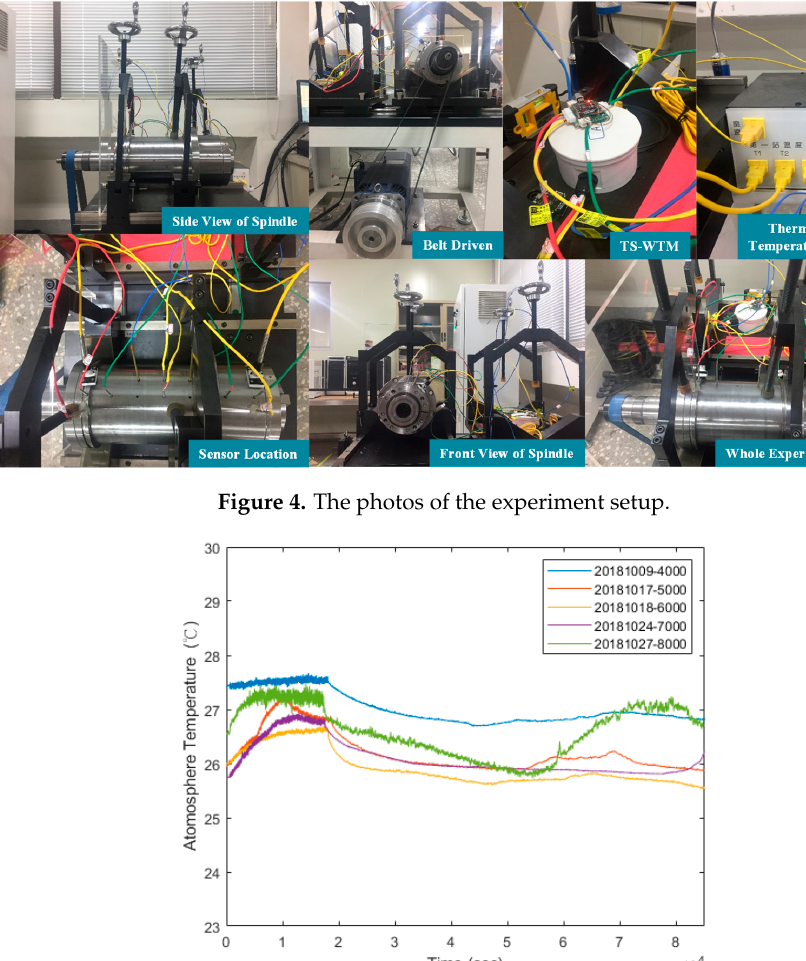
Figure 5. The variation of ambient temperature during a day.